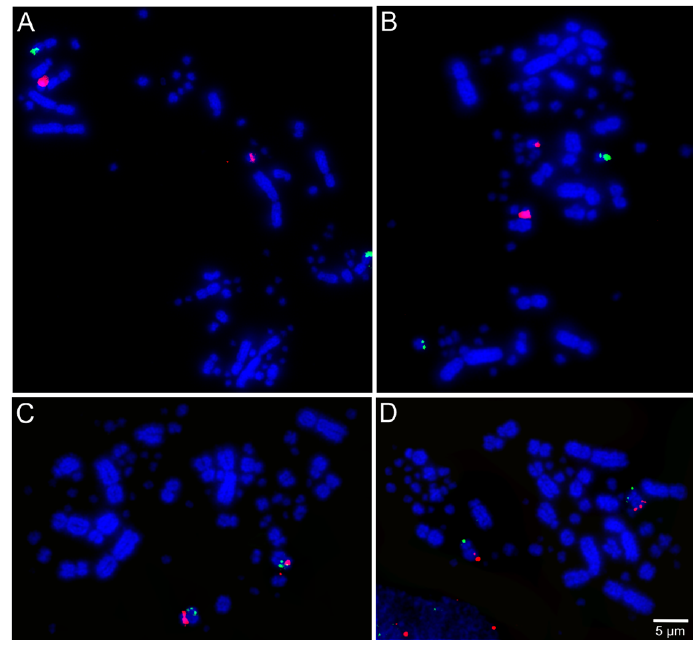
Figure 2. Examples of fluorescent in situ hybridization (FISH) experiments using chicken or zebra finch bacterial artificial chromosome (BAC) probes in Phalacrocorax brasilianus : ( A ) chicken macrochromosome 5 CH261-49B22 FITC and CH261-78F13 Texas red; ( B ) chicken macrochromosome 6 TGMCBA-382J4 FITC and CH261-49F3 Texas red; ( C ) chicken macrochromosome 9 CH261-183N19 FITC and chicken macrochromosome 10 CH261-115G24 Texas red; and ( D ) chicken microchromosome 11 CH261-154H1 FITC and chicken microchromosome 13 TGMCBA-321B13 Texas red.